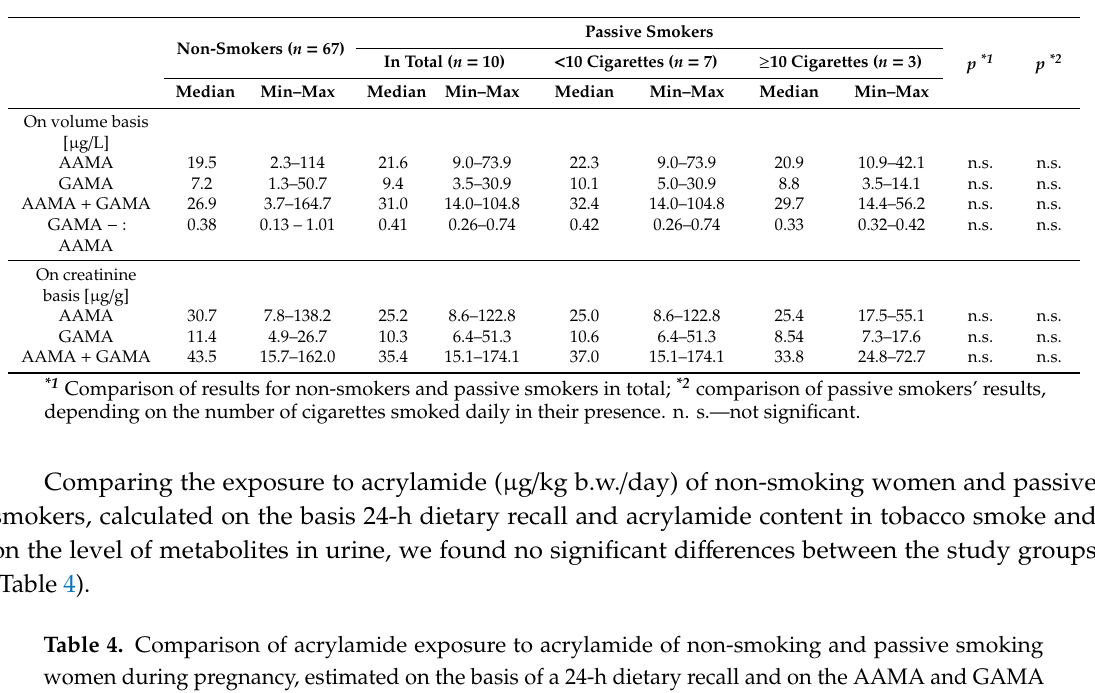
Table 3. Comparison of AAMA and GAMA levels in urine post-partum of non-smoking and passive smoking women during pregnancy.